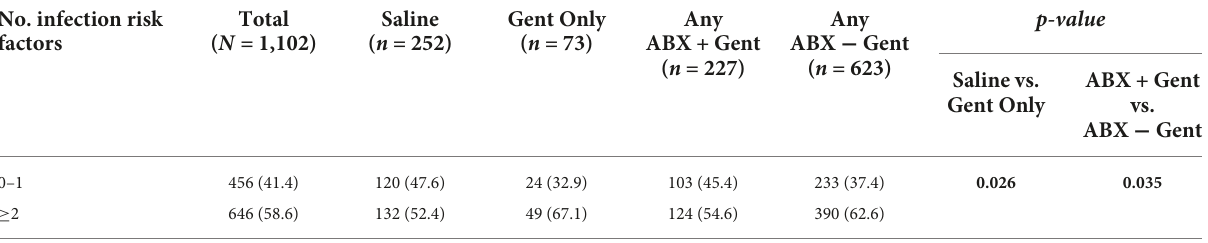
TABLE 6 Analysis by number of infection risk factors by treatment group.